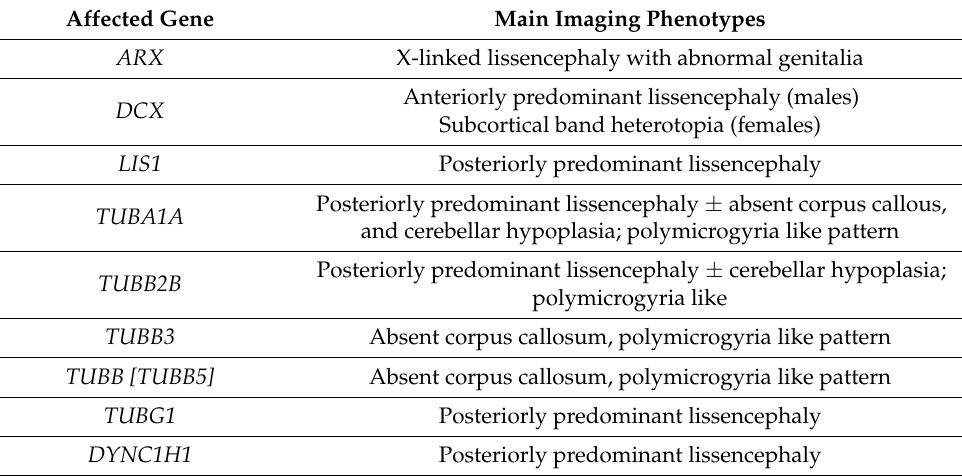
Table 2. Genes commonly associated to malformation of cortical development observed in families